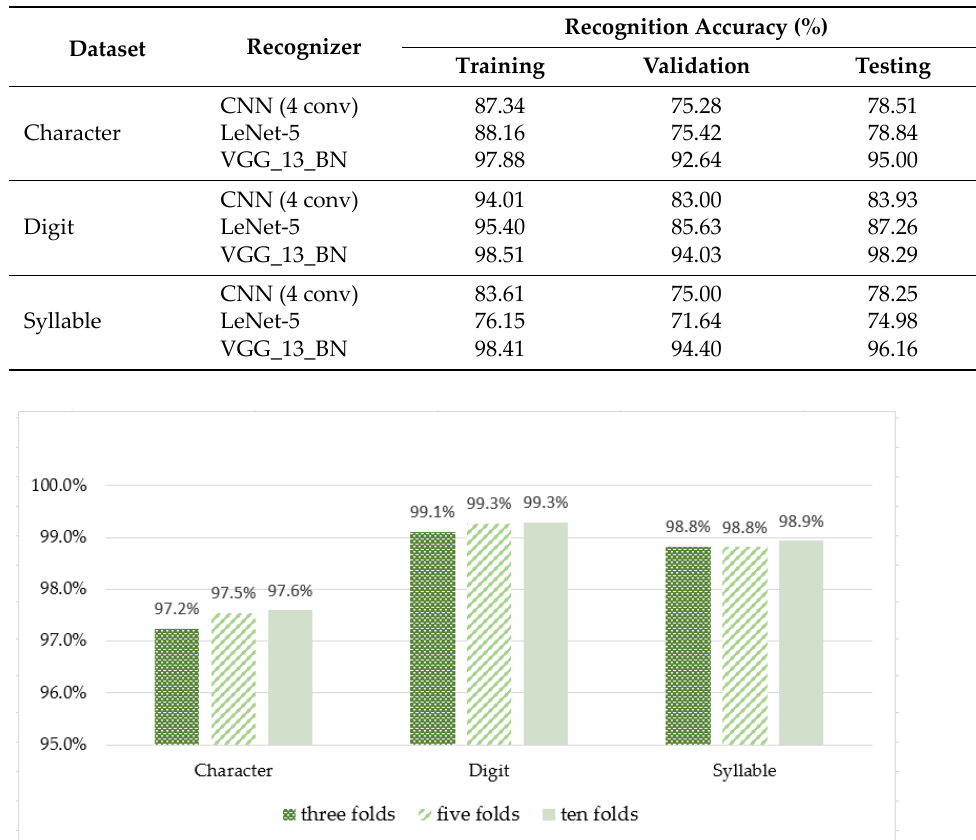
Table 4. An overview of the public datasets discussed in the paper and Burapha‑TH dataset.